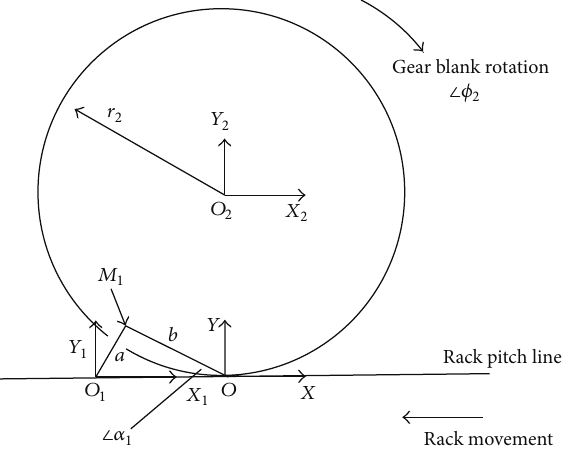
Figure 1: Involute profile generation. 𝛼 1 : pressure angle, 𝜙 2 : gear rotation angle corresponding to rack movement of 𝑏 1